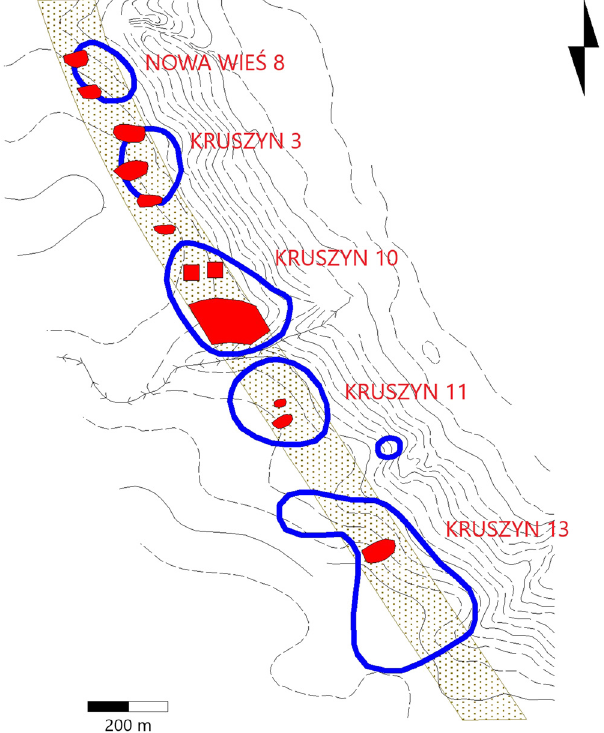
Figure 3: LBK settlement in the Kruszyn microregion. Red area – LBK occupation, blue lines – boundaries of sites according to survey, dotted area – motorway